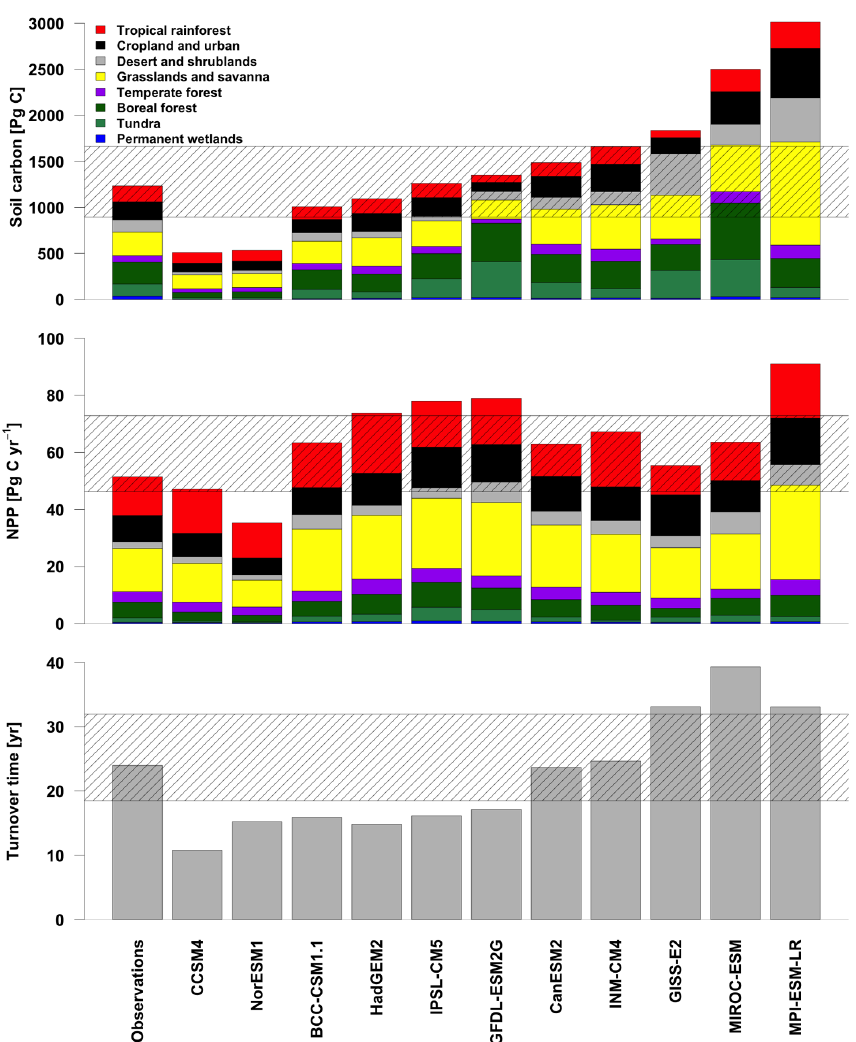
Fig. 2. Global soil carbon (top), net primary production (middle), and soil carbon turnover times (bottom) for observations and ESMs. Turnover times were calculated as HWSD carbon divided by MODIS NPP for the observations, and simulated global soil carbon divided by simulated global NPP for the ESMs. The gray hashed area on the top panel represents the 95% confidence interval for global soil carbon in the HWSD based on a qualitative uncertainty analysis (see text). The hashed area on the middle panel represents ± 2 standard deviations around the mean global NPP estimate from Ito (2011) based on empirical models. The hashed area on the bottom panel indicates the range of turnover times for global soil carbon found in the literature (Amundson, 2001; Raich and Schlesinger, 1992). For soil carbon and NPP, each global estimate is separated into individual biome components according to the legend shown in the top